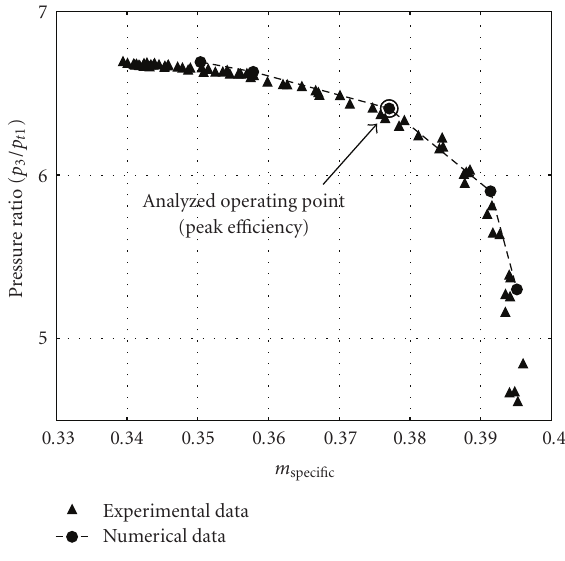
Figure 5: Pressure ratio of the compressor stage ( Ω R = 0 . 927 . Ω nom